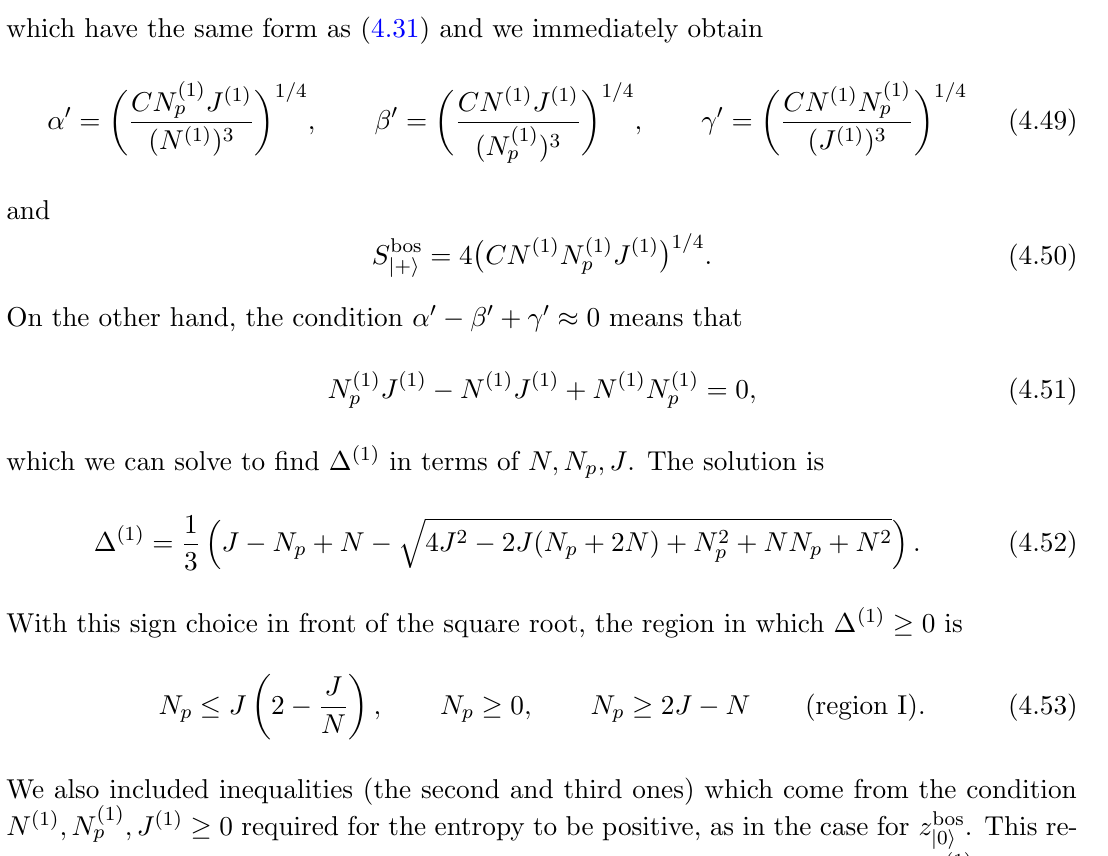
Figure 4 . The regions in which states counted by z bos blue region, which is given by (4.53), the strand j + i (cid:1) (1) =